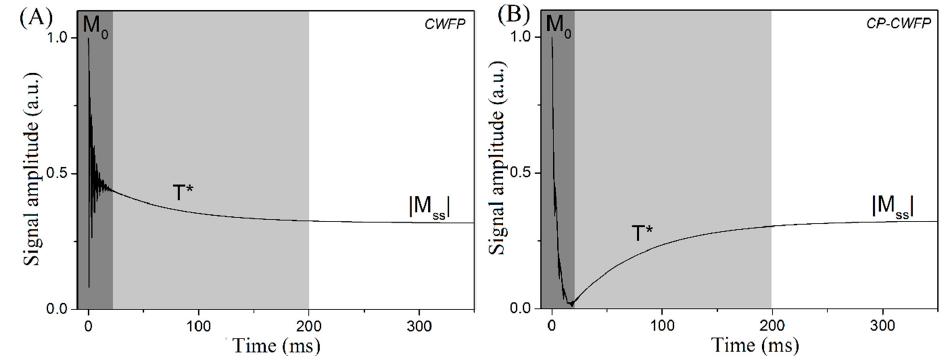
Figure 8. Numerically simulated signals showing the evolution of the ( A ) CWFP and ( B ) CP-CWFP signal magnitudes from the first pulse to the stationary state (|M ss |) using T 1 = 150 ms, T 2 = 50 ms, T p = 0.3 ms, and T 2 * = 20 ms. When the oscillation ends, the signal was named a quasi-stationary state (QSS) (transition between dark and light grays regions). The background color indicates the first transient oscillating signal (dark grey), the slowly signal decay with time constant T* (light grey), given by Equation (5), until it reaches the constant steady state amplitude |M ss | (white region). For θ = 90° and Φ = (2𝑛 + 1)𝜋 , the transient time T* for the CWFP and CP-CWFP sequences in